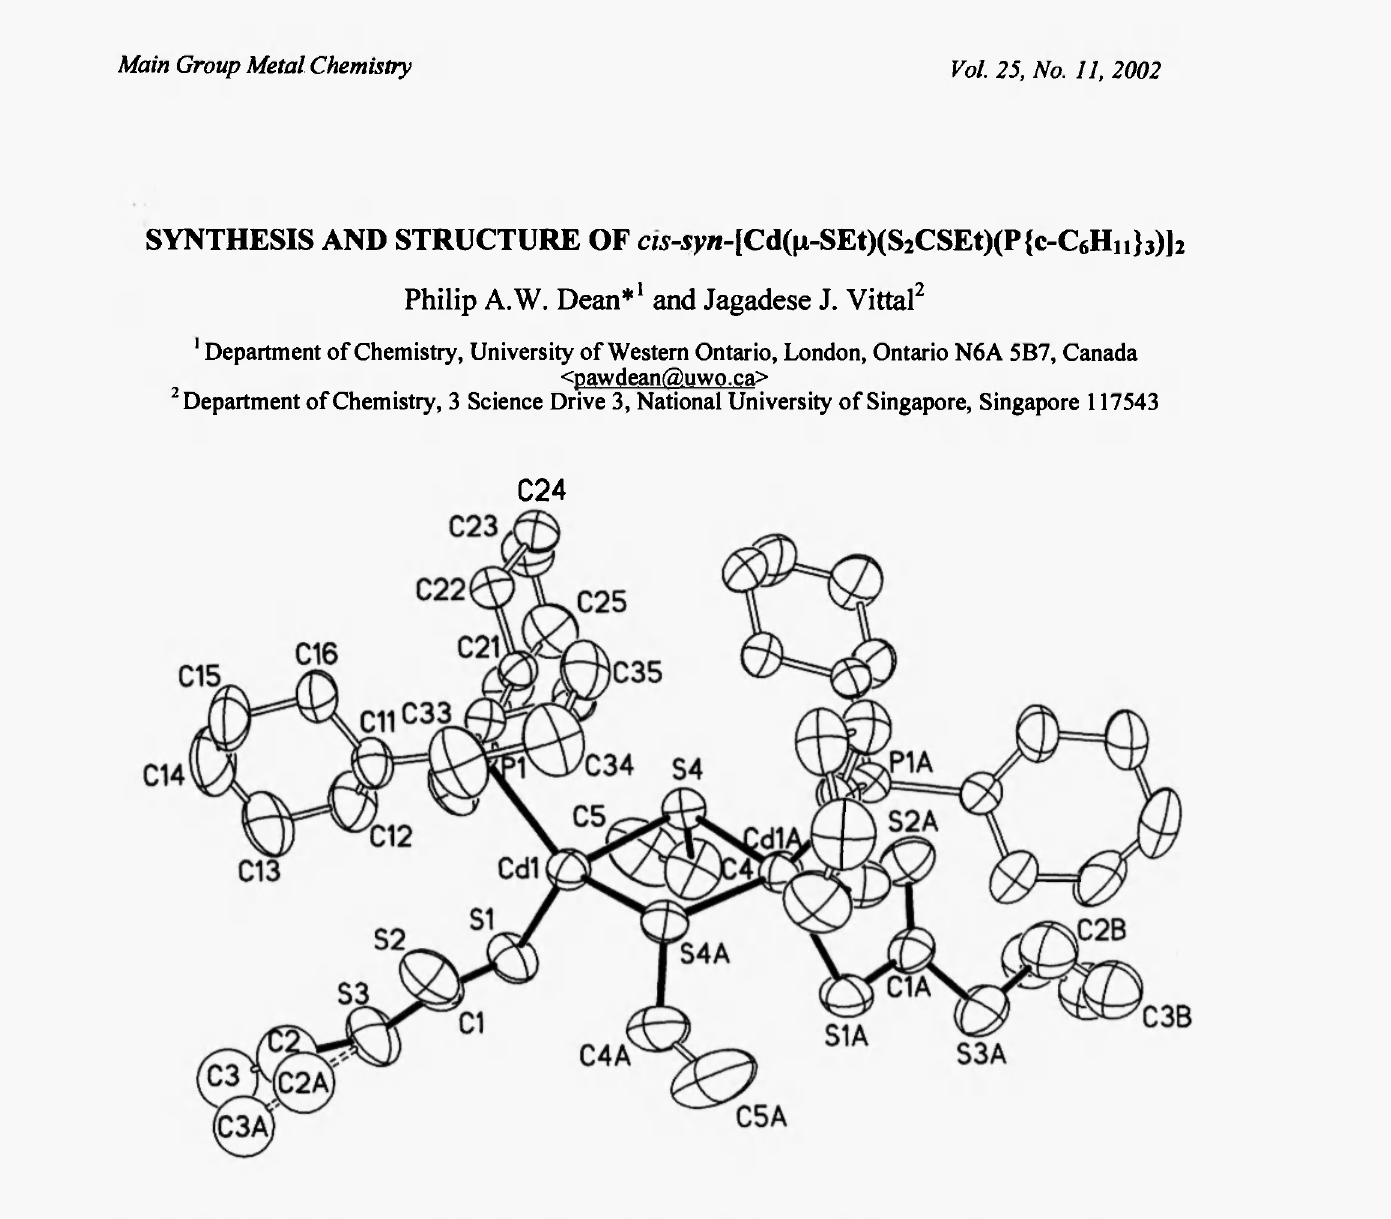
Fig. 1. An ORTEP diagram of 1 showing 50% probability displacement ellipsoids. The two positions of the disordered terminal SC(S)SEt groups are shown. Selected bond lengths [Ä] and angles [°]: Cd(l)-P(l), 2.640(2); Cd(l)-S(l), 2.593(2); Cd(l)...S(2), 3.157(3); Cd(l)-S(4), 2.693(2); Cd(l)-S(4A) a , 2.578(2); C(l)- S(l), 1.725(6); C(l)-S (2), 1.688(6); C(l)-S(3), 1.760(6); C(2)-S(3), 1.88(1); C(U)-P(1), 1.865(5); C(21)- P(l), 1.875(5); C(31)-P(l), 1.862(5); C(4)-S(4), 1.866(7); S(4)-Cd(l)-S(4A) a , 90.65(6); Cd(l)-S(4)-Cd(lA) a , 88.94(6); P(l)-Cd(l)-S(l), 114.39(6); P(l)-Cd(l)-S(4), 103.37(5); P(l)-Cd(l)-S(4A) a , 118.07(5); S(l)- Cd(l)-S(4), 103.32(5); S(l)-Cd(l)-S(4A), 120.28(6); Cd(l)-S(l)-C(l), 94.7(2); Cd(l)-S(4)-C(4),. 104.1(3); Cd( 1 A) a -S(4)-C(4), 100.0(2); S(l)-C(l)-S(2), 124.6(3); S(l)-C(l)-S(3), 111.1(3); S(2)-C(l)-S(3),